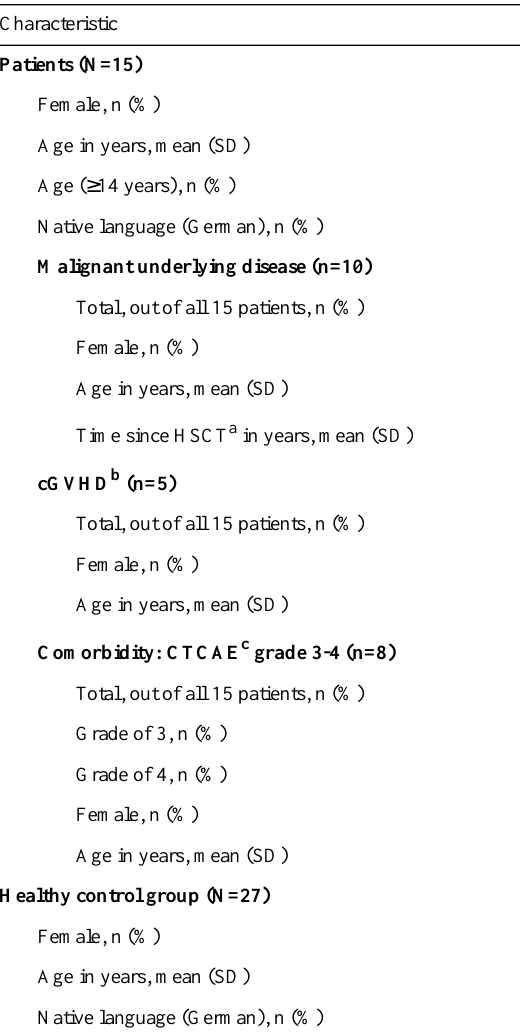
Table 1. Participant